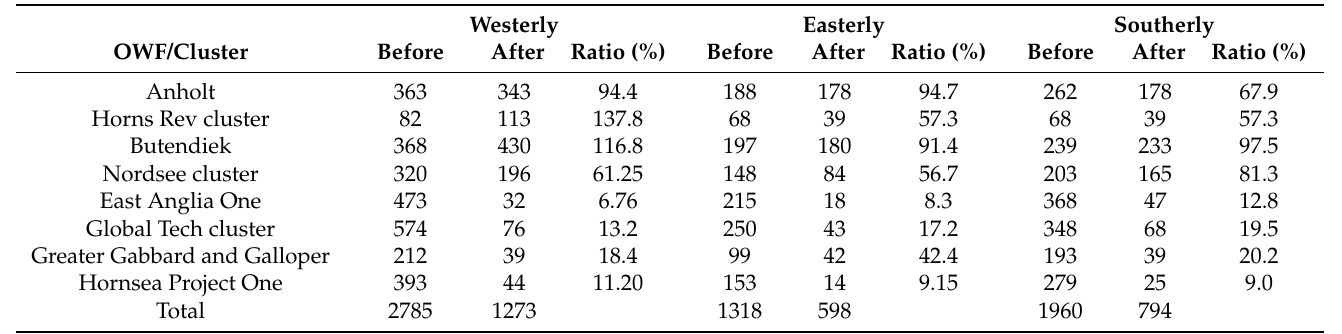
Table 3. Westerly, easterly, and southerly classified SAR wind maps for the periods before and after commissioning of the selected OWFs and